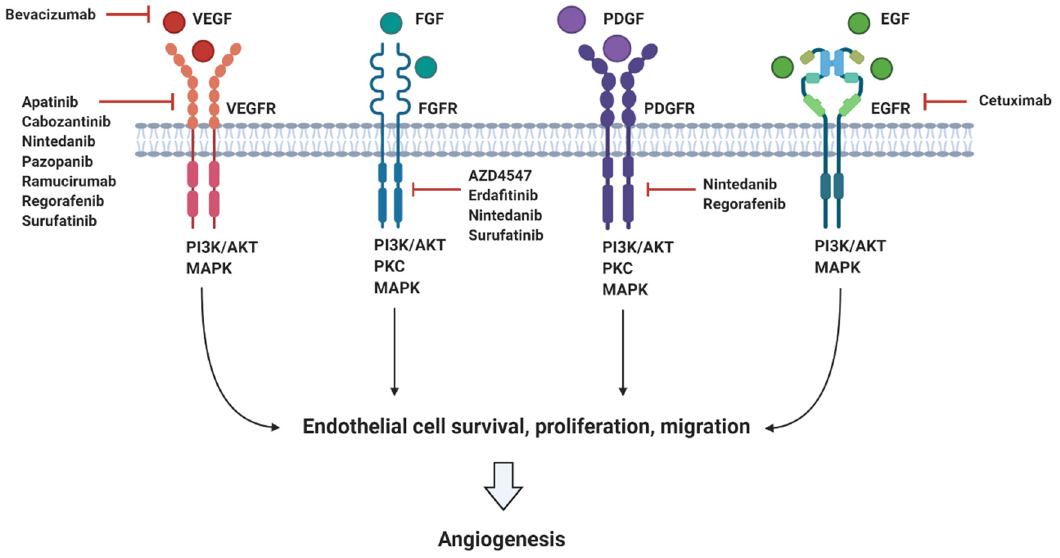
Figure 2. Summary of the main pro-angiogenic factors (VEGF, FGF, PDGF, and EGF), their corresponding receptors (VEGFR, FGFR, PDGFR, and EGFR), and targeted angiogenic inhibitors currently in clinical trials for pancreatic cancer.